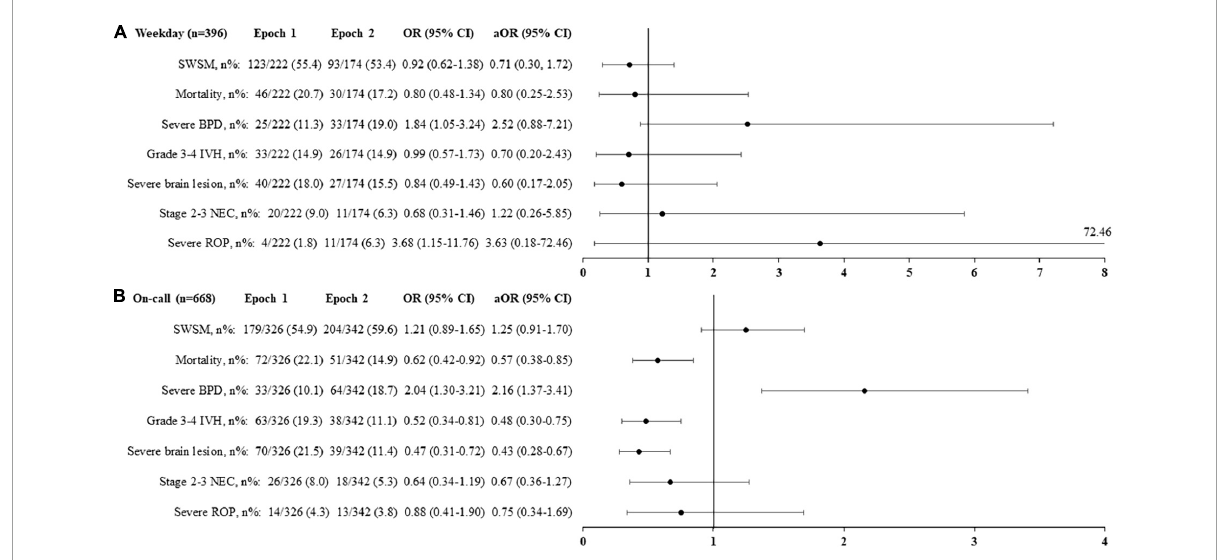
FIGURE4 Primary and secondary outcomes according to the epochs and the period of birth [Weekday: (A) , On-call: (B) ] in the overall population. Adjusted odds ratio (aOR), weighted by the propensity score, and their 95% confidence interval (95% CI) shown of the figure are expressed vs. Epoch 1. On-call: defined as birth in weekdays between 6.30 p.m. and 8.30 a.m., in weekends and public holidays. SWSM, survival without severe morbidity; BPD, bronchopulmonary dysplasia; IVH, intraventricular hemorrhage; NEC, necrotizing enterocolitis; ROP, retinopathy of prematurity.